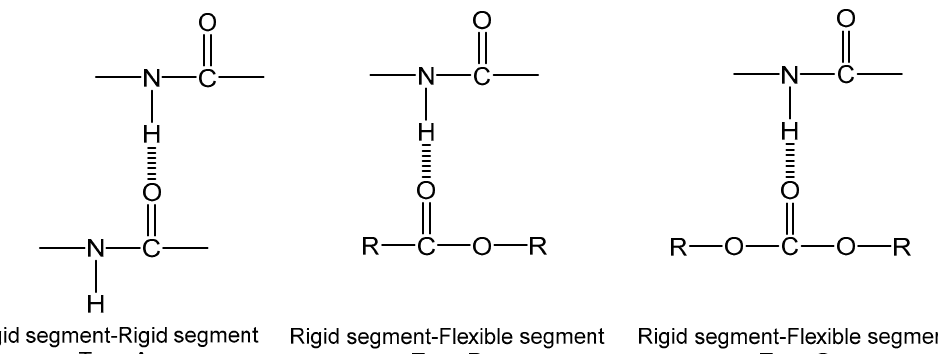
Scheme 1. Types of associations through hydrogen bonds that may exist in polyurethane samples.